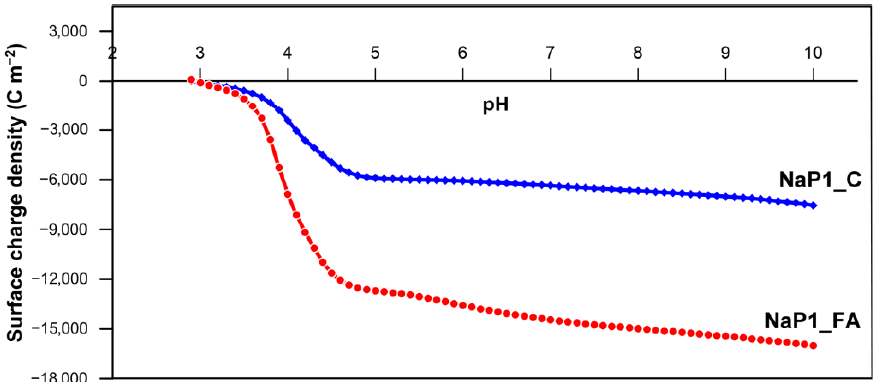
Figure 6. Surface charge density of NaP1_C and NaP1_FA as a function of solution pH.